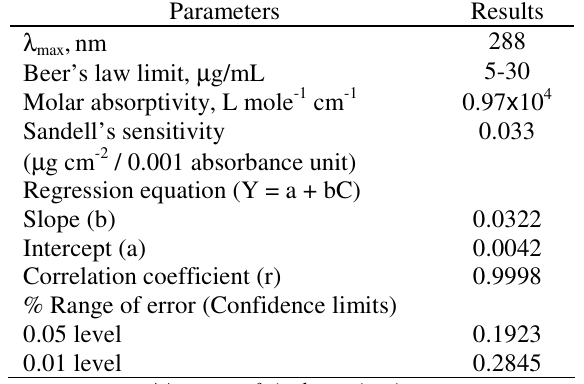
Table 1. Optical characteristics of duloxetine